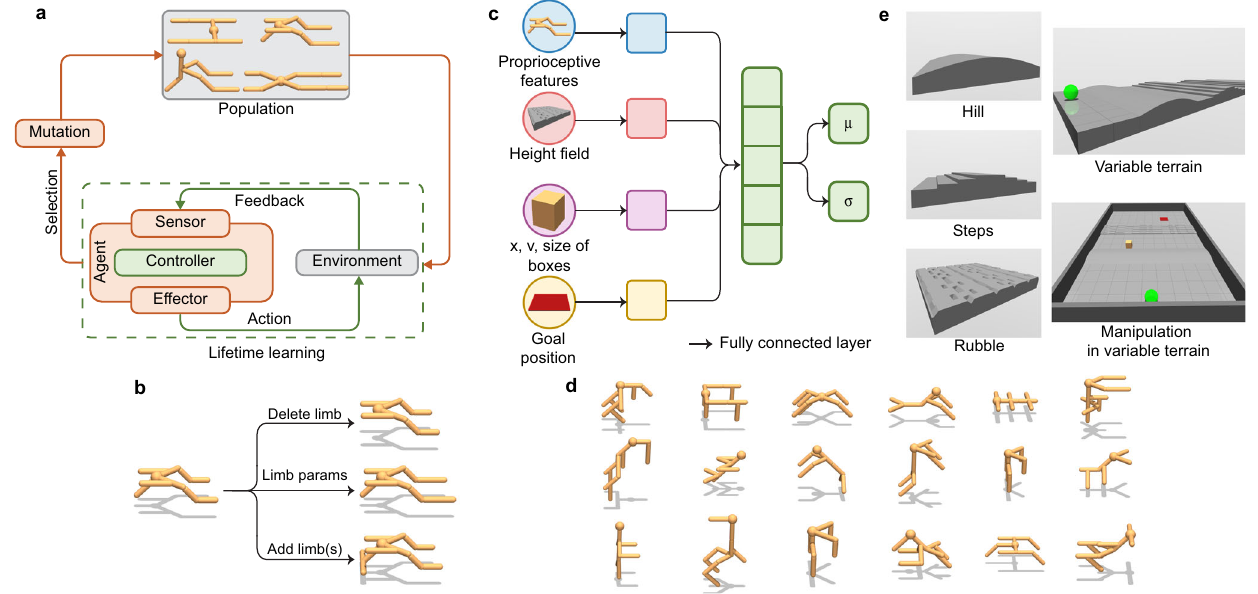
Fig. 1 DERL overview. a DERL is a general framework to make embodied agents via two interacting adaptive processes. An outer loop of evolution optimizes agent morphology via mutation operations, some of which are shown in ( b ) and an inner reinforcement learning loop optimizes the parameters of a neural controller ( c ). d Example agent morphologies in the UNIMAL design space. e Variable terrain consists of three stochastically generated obstacles: hills, steps, and rubble. In manipulation in variable terrain, an agent must start from an initial location (green sphere) and move a box to a goal location (red